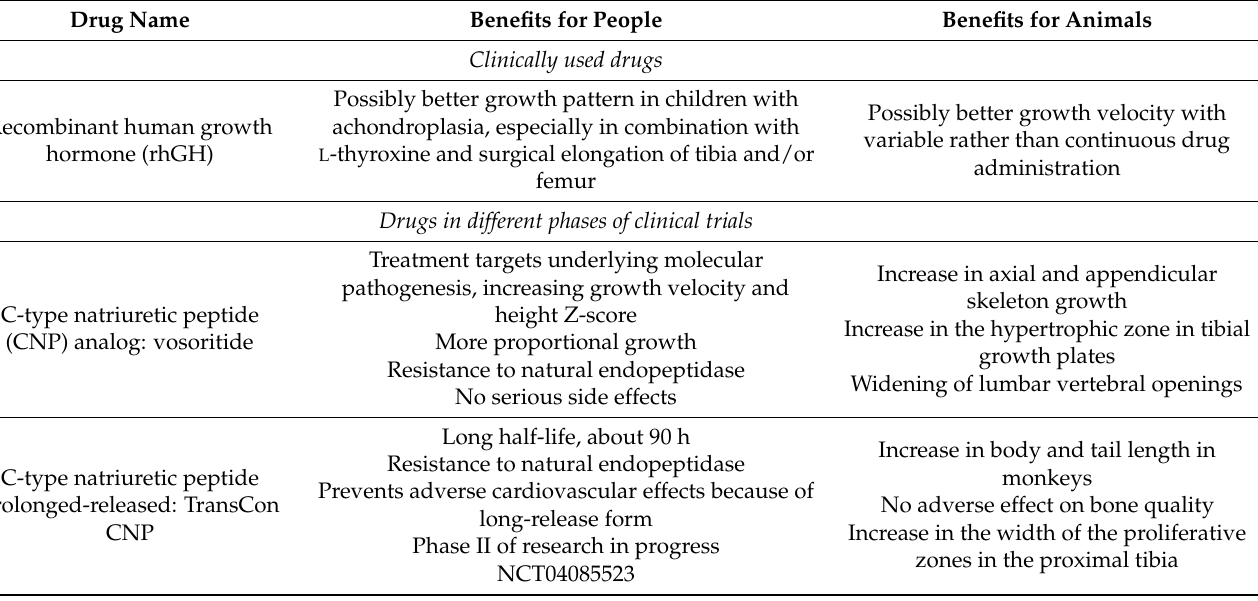
Table 2. Benefits of different drug therapies in